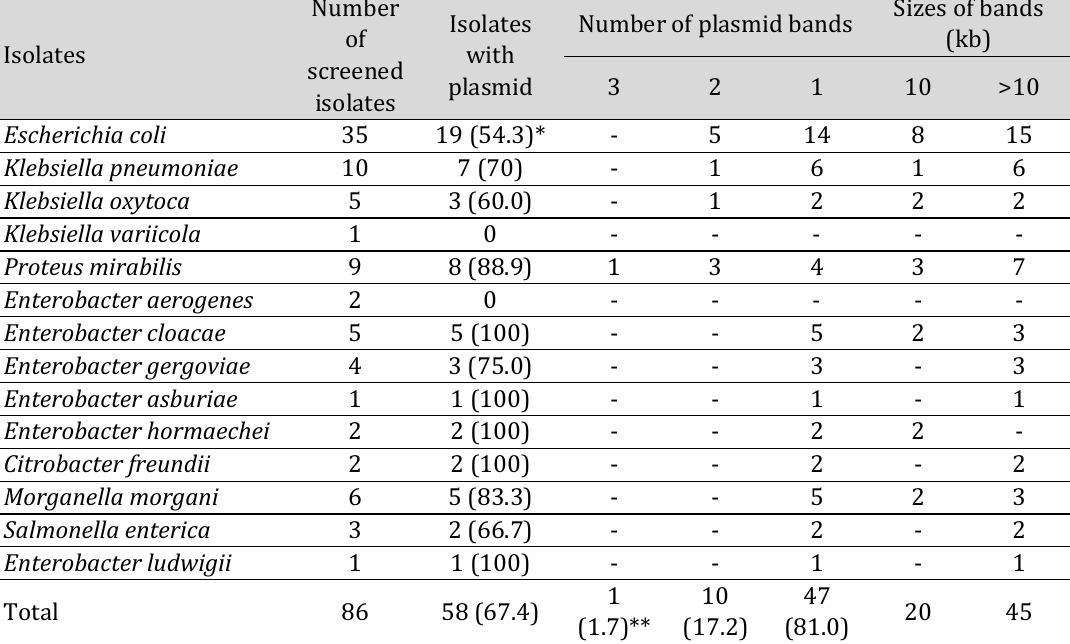
Table 4. Plasmid profile analysis of MDR Enterobacteriaceae from water sources in Adamawa-North senatorial